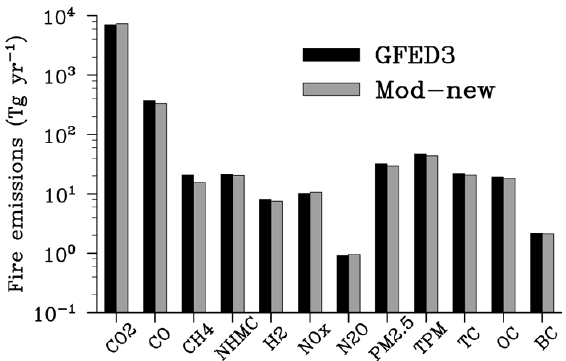
Fig. 14. 1997–2004 mean annual global emissions of trace